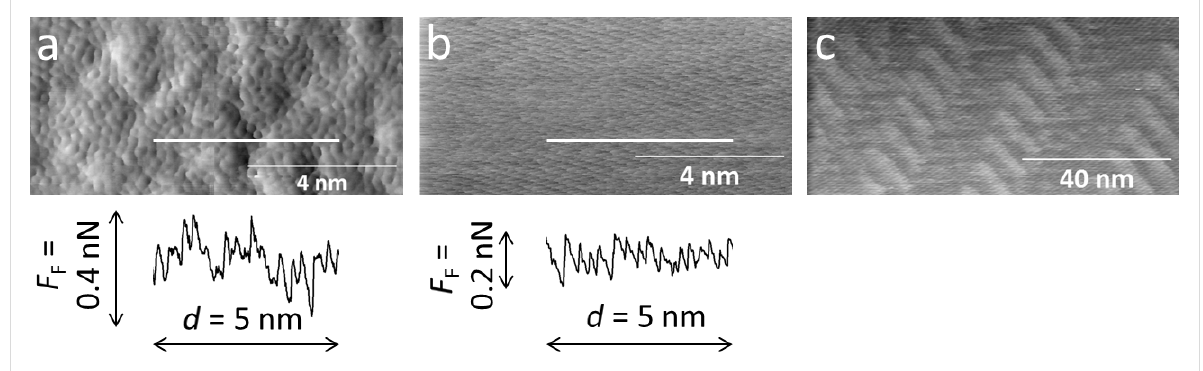
Figure 1: Friction force maps for a) an oxidized Si(100) surface scanned with an intact Ar-sputter cleaned SiO x /Si tip, b) Au(111), and c) the topogra- phy of the Au(111) herringbone reconstruction scanned with an intact SiO x /Si tip. One line was extracted from a) and b) to visualize the stick–slip pattern on Si(100) and on Au(111).